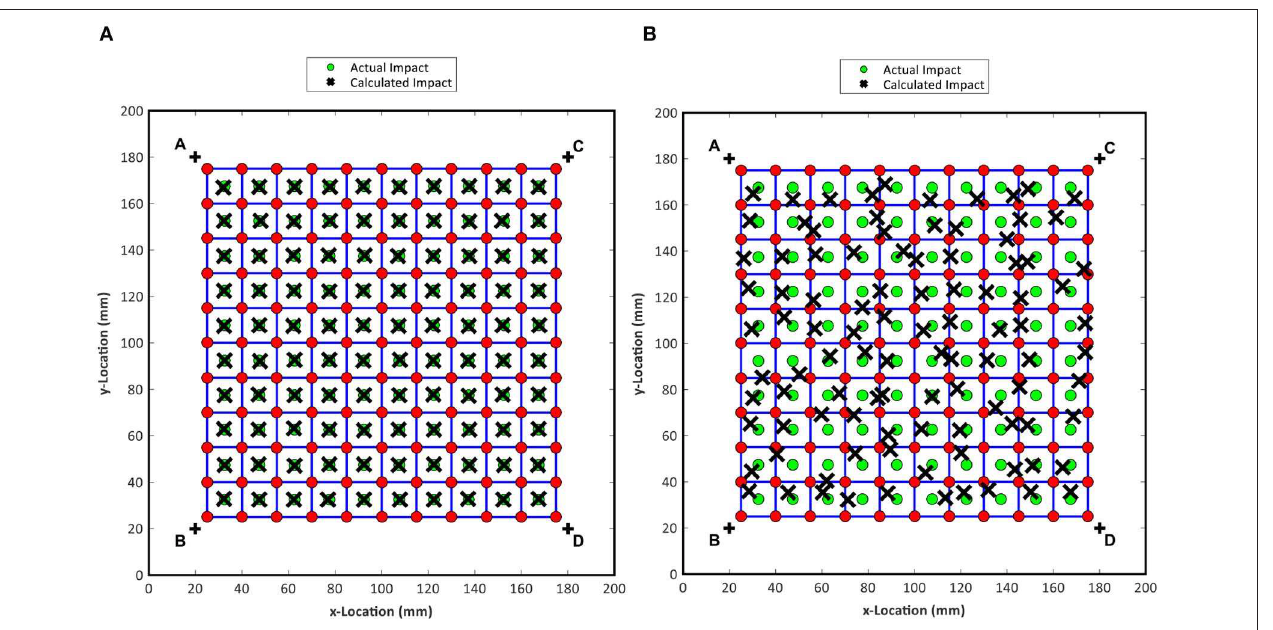
In this case, the concept of grid refinement factor 2 means that the number of baseline points used is reduced by 2 in relation to the original grid. Such a training corresponds to the baseline cell sides being doubled, making the baseline grid coarser and reducing the number of excitation points. Figure 3 shows the original and the refined baseline grid dimensions as well as the